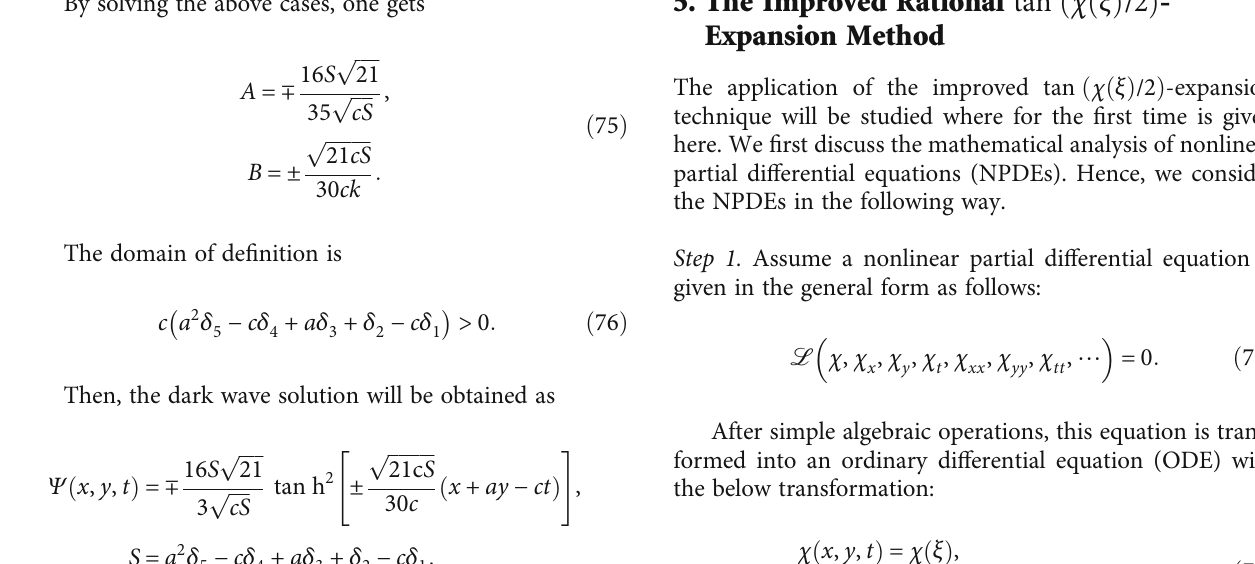
= : 5, a = 1 : 5, a = 2, a = 1, Ω = 1 : 9, Ω 1 2 3 4 2